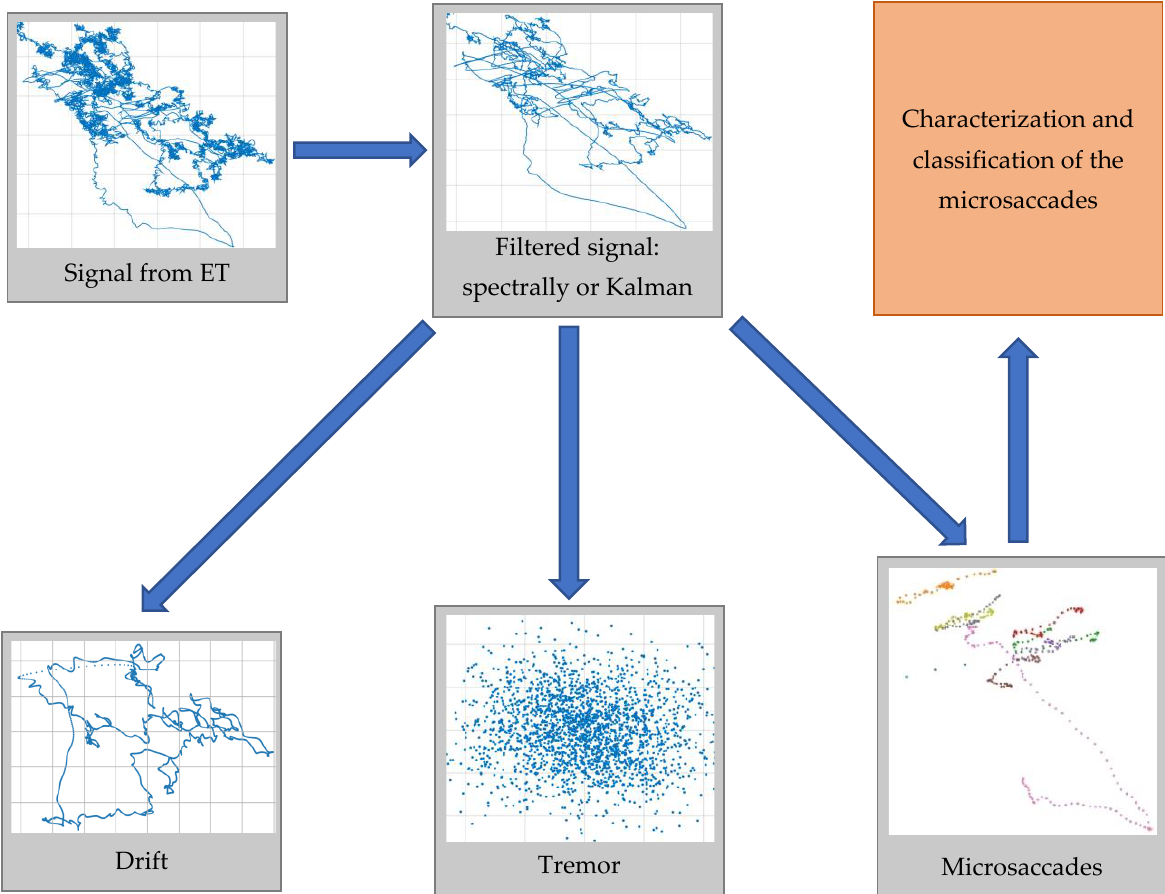
Figure 1. The preprocessing steps of filtration of the data and separation of the three different fixative eye